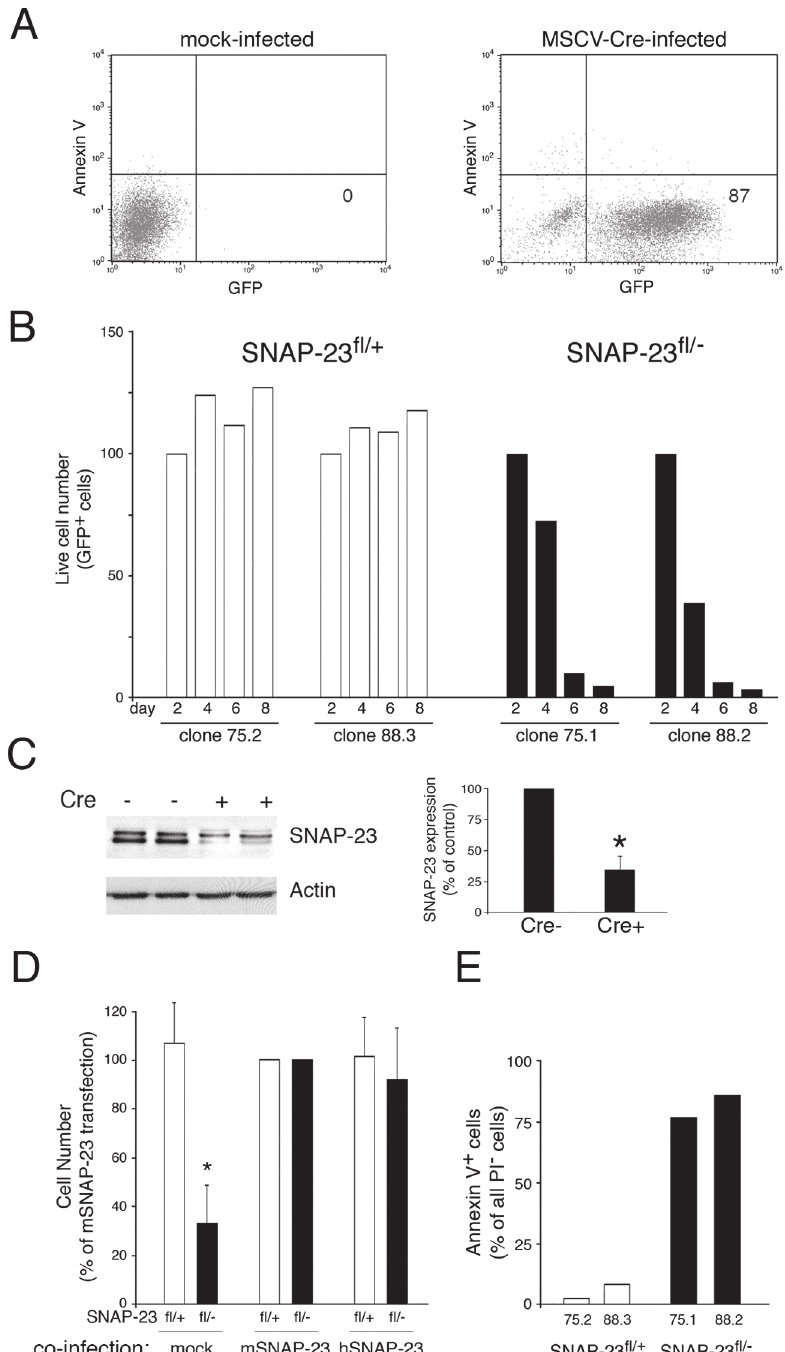
Fig 6. Deletion of SNAP-23 leads to acute death of MEFs. MEF lines were generated from SNAP-23 fl/+ mice (clones 75.1 and 88.2) or SNAP-23 fl/- mice (clones 75.2 and 88.3). (A) Infection of a typical SNAP-23 fl/+ MEF culture infected with empty retrovirus (left panel) or GFP-Cre retrovirus (right panel) shows that two days after infection the vast majority of MEFs were viable (Annexin V - ) and expressed GFP-Cre. (B) The indicated MEF lines were infected with GFP-Cre-expressing retrovirus and the number of live cells present in each culture (based on staining with PI) was determined at different times. The absolute cell recovery in each condition was expressed relative to the amount of cells present two days after infection (control experiments showed that there was no Cre-dependent cell death in any line after only two days of infection). The data shown are representative of two independent experiments analyzed at day 2, 4, 6, 8 and one